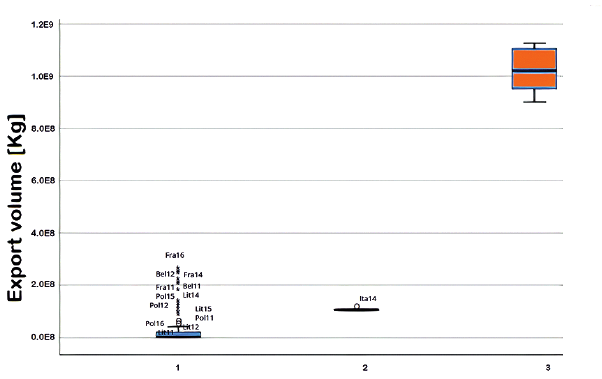
Figure 11. Post-crisis box diagram of export variable according to the clusters of the first two-stage clustering level (source: own elaboration)